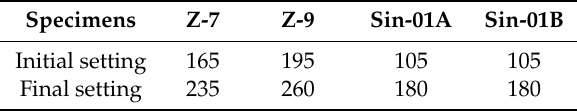
Table 4. Results of setting time of the specimens.